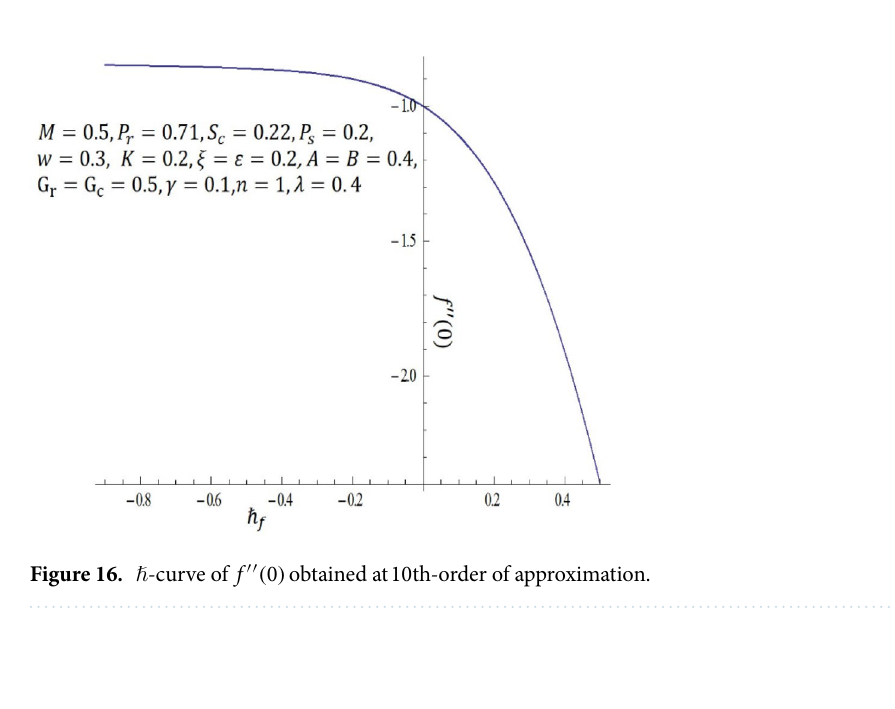
Figure 15. Effect of τ on concentration profile when n = 4 .